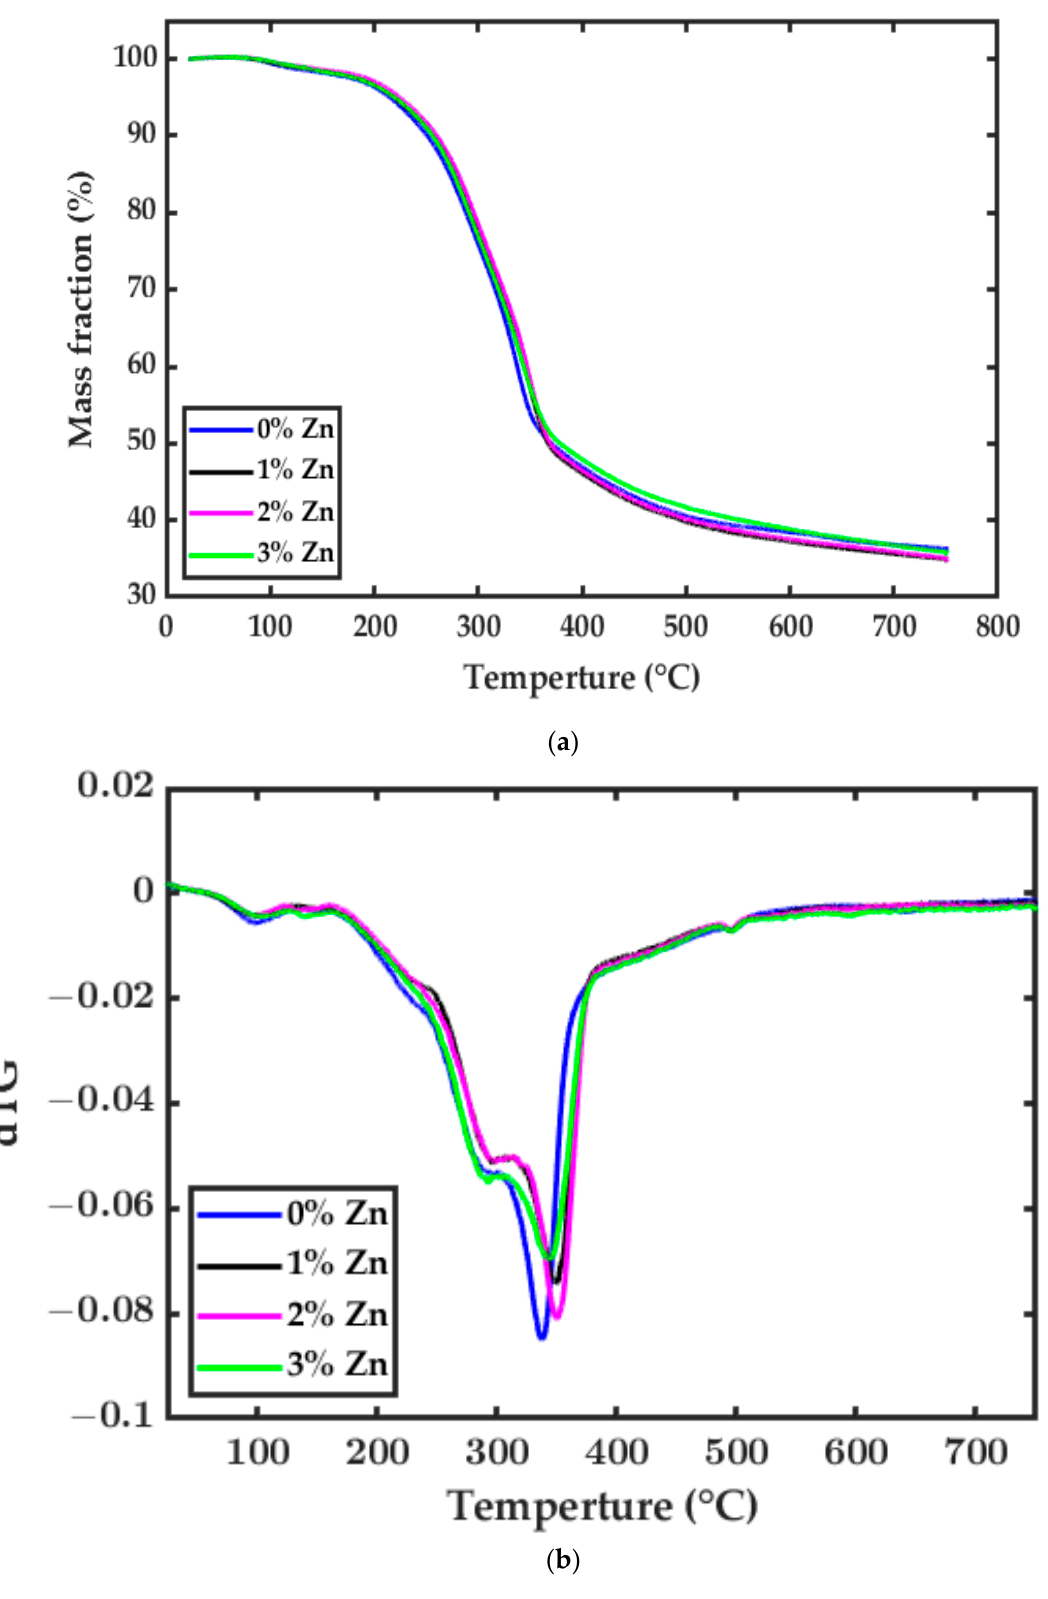
Figure 1. EFB at 10 K/min heating rate: ( a ) Mass loss curve for samples with 0%, 1%, 2%, and 3% catalyst. ( b ) DTG curves for samples with 0%, 1%, 2%, and 3% catalyst.